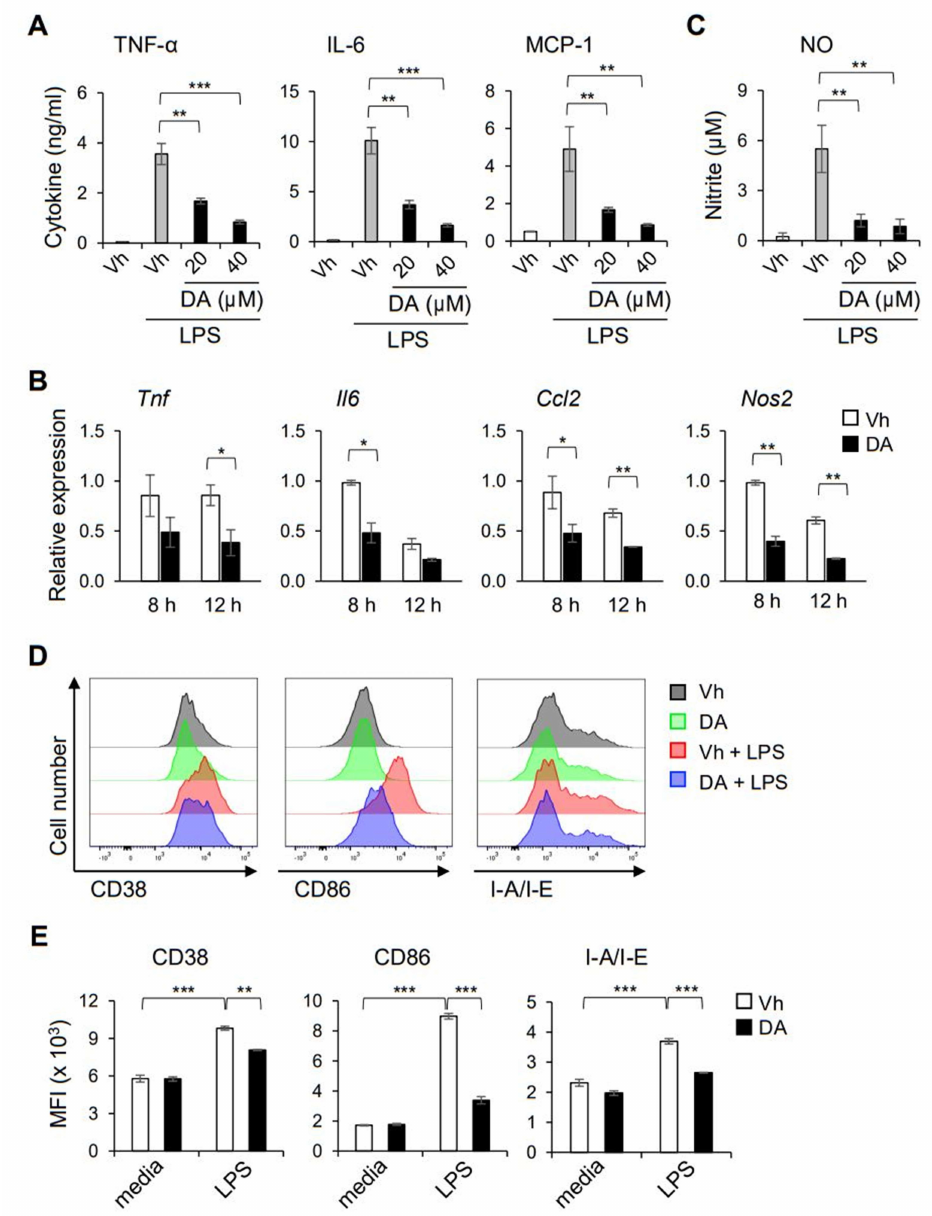
Figure 5. DA inhibited the LPS-induced functional activation of pro-inflammatory macrophages. ( A ) BMDMs were pretreated with the indicated concentrations of DA and activated with 200 ng/mL LPS for 8 h. Production of TNF- α , IL-6 and MCP-1 in the culture supernatant was determined by CBA; n = 4. ( B ) Amounts of nitrite in the culture supernatant were measured. ( C ) BMDMs were pre-treated with 20 µ M of DA followed by stimulation with LPS for the indicated time. LPS-induced expression of mRNA encoding the indicated genes was quantitated by real-time PCR; n = 3. ( D , E ) BMDMs were pretreated with 20 µ M DA and activated with LPS for 24 h. Cell surface expression of CD38, CD86 and I-A/I-E was analyzed by flow cytometry. Representative histograms ( D ) and the mean ( ± S.D.) MFI of the indicated surface markers ( E ) are shown; n = 3; * p < 0.05, ** p < 0.01, *** p <